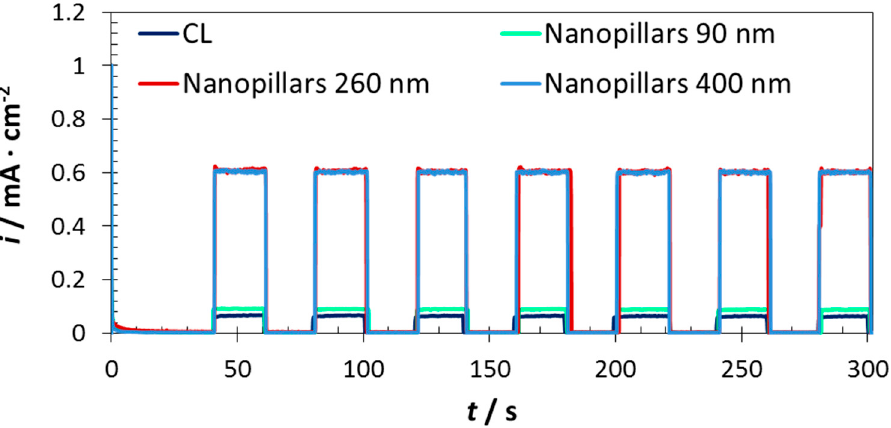
Figure 8. Chopped-light chronoamperometry measurements at 0.5 V (vs. Ag/AgCl) of the pho- toanodes fabricated on Ti substrates, under visible light ( λ > 420